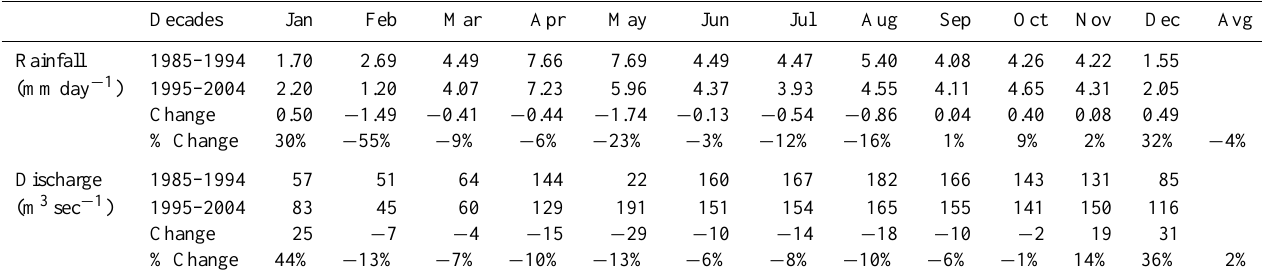
Table 2. Seasonal variation of rainfall and